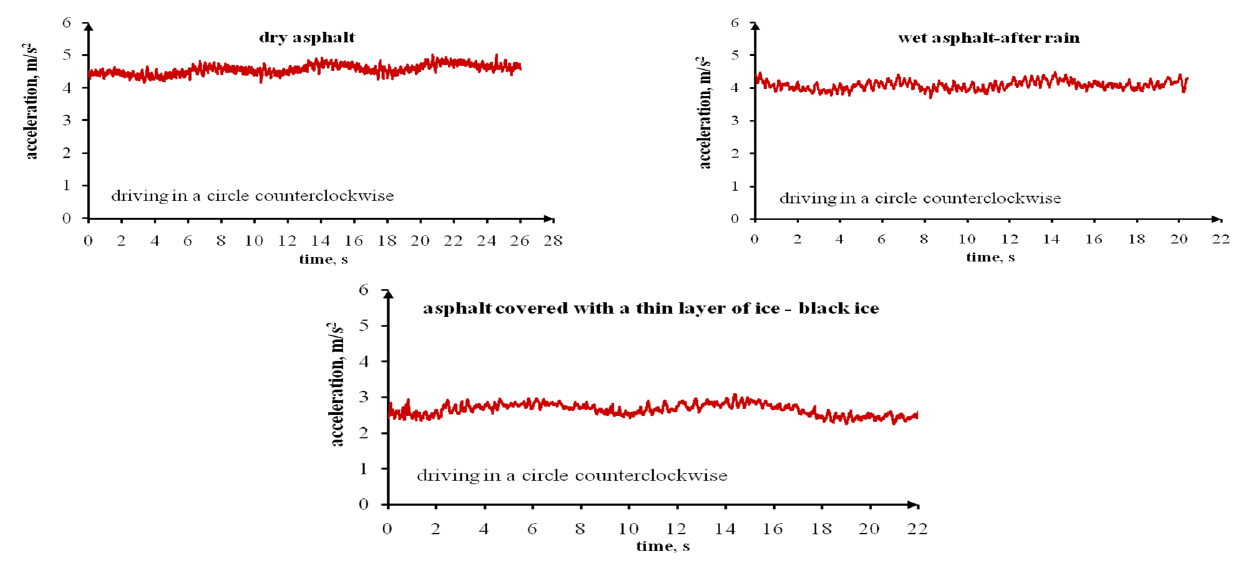
Figure 6. The Ford Transit’s lateral accelerations when driving in a circle counterclockwise (to the left), with the highest possible speed on a dry, wet (after rain) and icy asphalt surface.